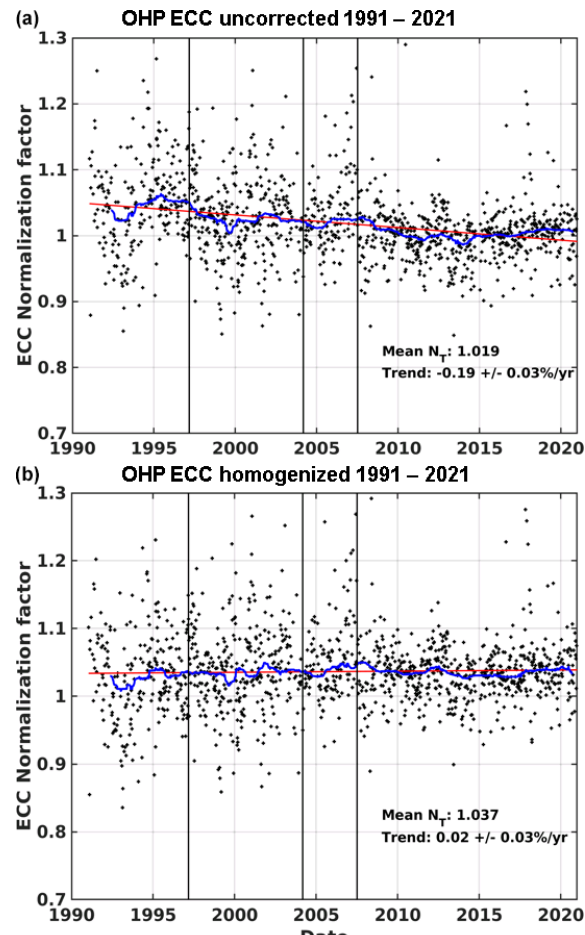
Figure 4. Time evolution of the OHP ECC normalization factor ( N T ) from 1991 to 2021 before (a) and after homogenization (b) . The black lines correspond to the major ozonesonde changes in 1997, 2004 and 2007 (see Fig. 2). The thick blue lines are the 100- point, centered, moving averages. N T linear trends are shown in red, and the slope and its uncertainty with a 95% confidence are given in percent per year (%yr − 1